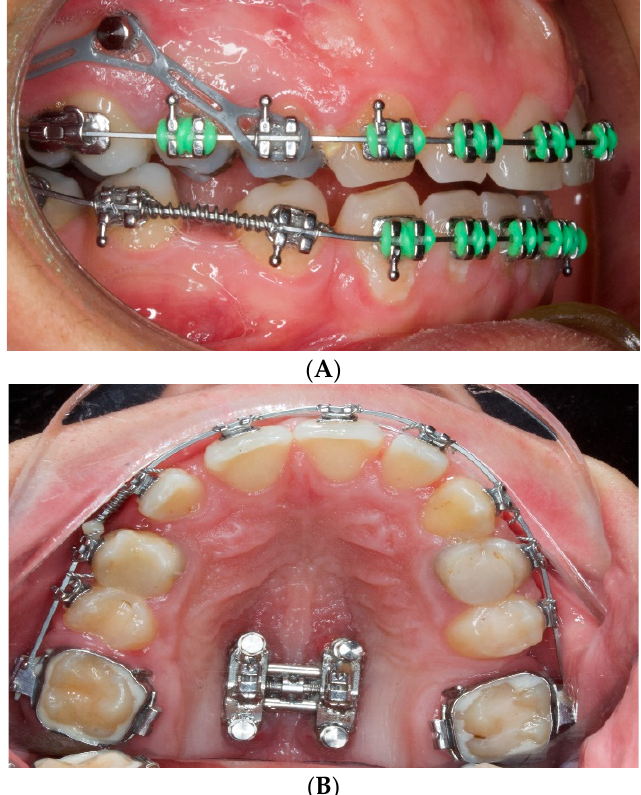
Figure 1. Mini-implants used in orthodontic therapies. ( A ) As anchorage for teeth movement. ( B ) To support a maxillary expander [5].